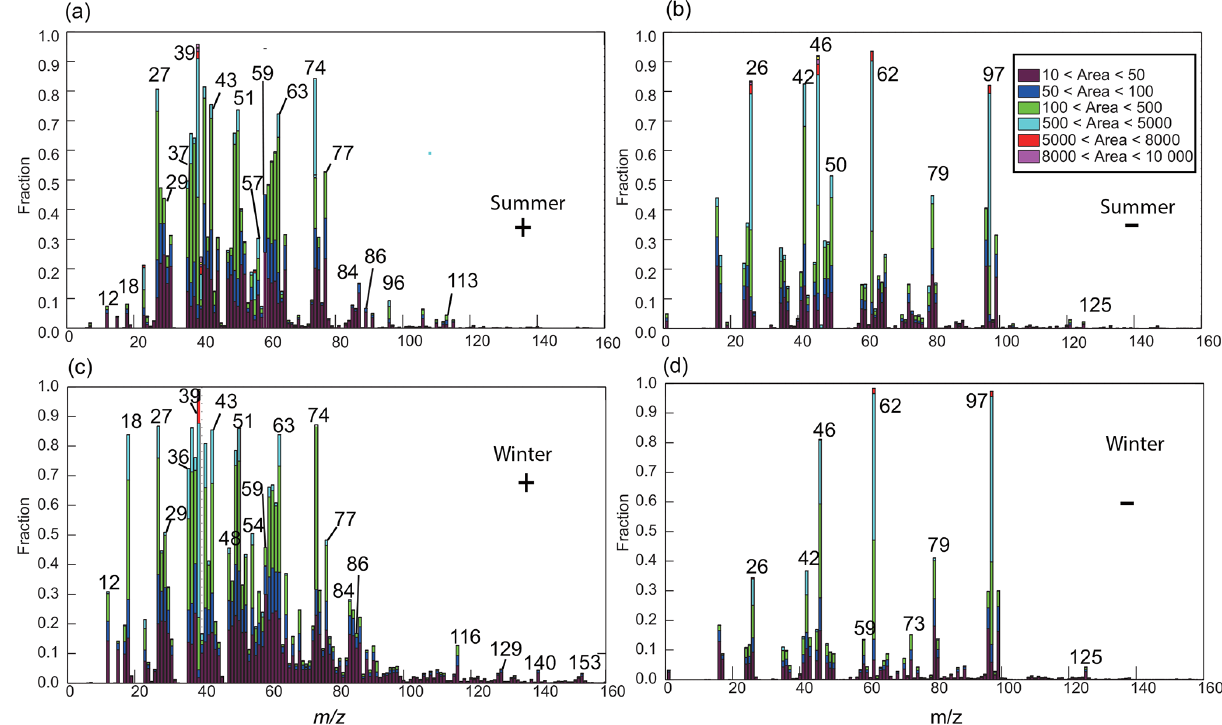
Figure 1. (a, c) The positive digital mass spectrum of amine-containing particles during summer and wintertime, respectively; (b, d) the negative digital mass spectrum during summer and wintertime, respectively. The ion height indicates its fraction in the amine-containing particle dataset, and the stacked color map indicates the ion peak area range.